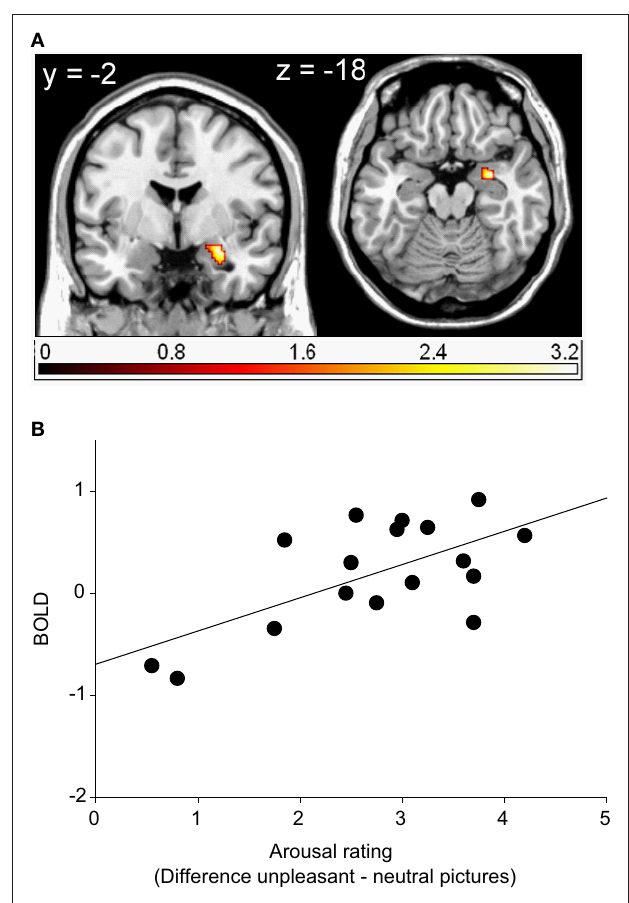
Figure 3 | region of interest (rOi) activation. (A) Cluster of significant correlation between right amygdala activation (peak voxel at 30, − 2, − 18) of the contrast unpleasant relative to neutral pictures and subjective arousal overlaid on a single subject T1 scan (overlay threshold: p < 0.05; minimum cluster size of k = 5). Color-coded t-values are shown. (B) Correlation between right amygdala activation (peak voxel at 30, − 2, − 18) of the contrast unpleasant relative to neutral pictures and subjective